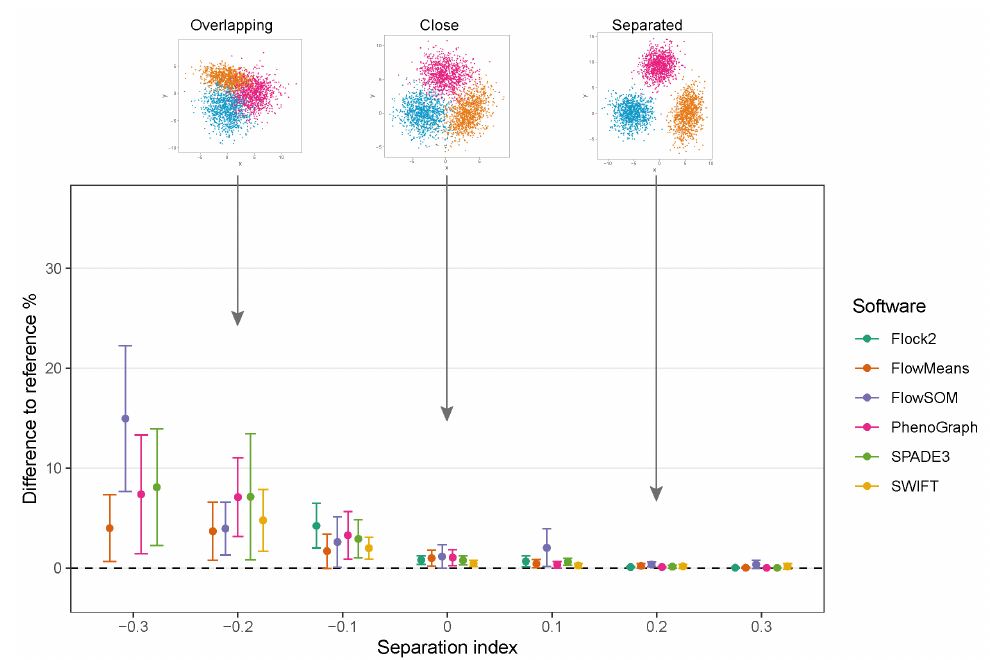
Figure 5. Performance of different software with a three-cluster separation